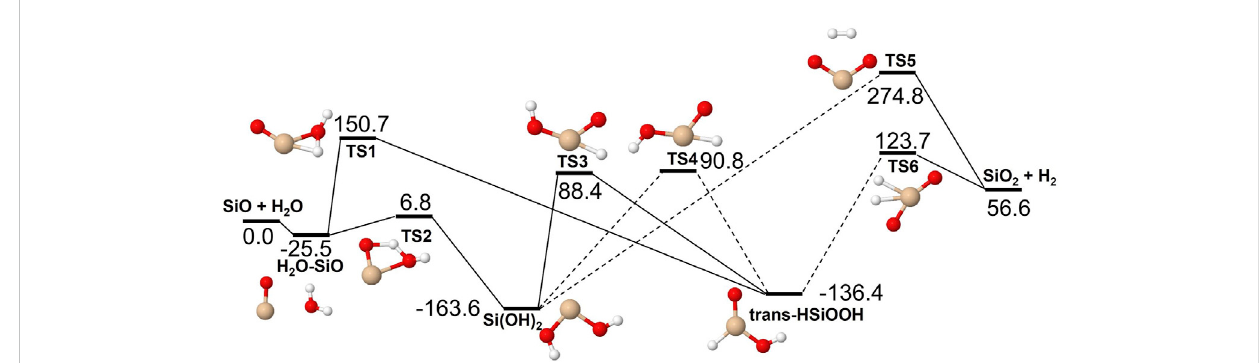
FIGURE 3 Potential energy surface based on M06 calculations for the SiO + H 2 O reaction as implemented in the RRKM calculations. The energies are given in kJ/mol and include vibrational zero-point energy corrections. Dashed lines indicate that the reaction step has been simpli fi ed by combining several similar intermediate isomers.